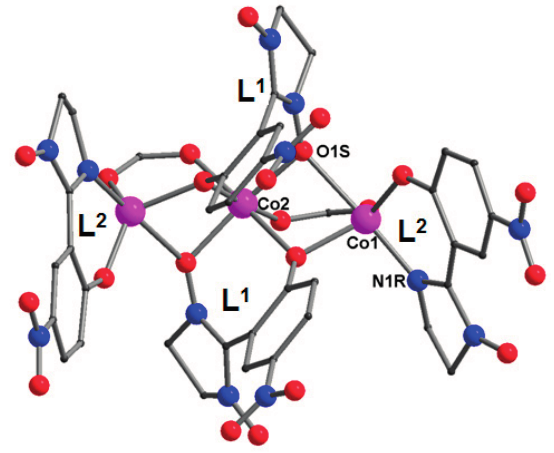
Figure 1. Trinuclear [ С o 3 (Piv) 2 L 1 2 L 2 2 ] molecule. Hereinafter, small black balls, С ; magenta, Co; red, O; blue, N; the H atoms and the CH 3 and Bu t groups are